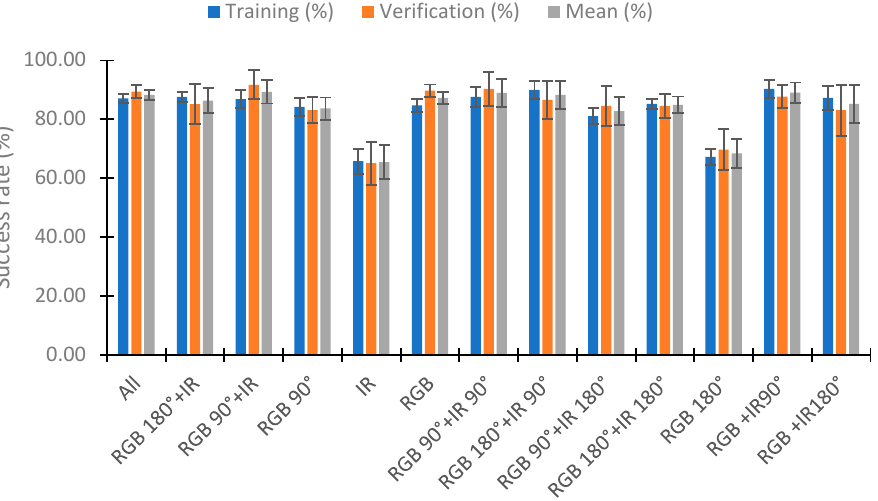
Figure 20. Success rate in the neural network with the use of IR and RGB lights in the different angles.